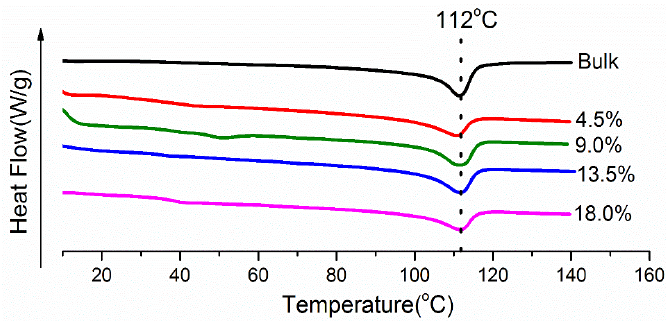
Figure 5. Differential scanning calorimetry (DSC) curves of the Fe 3 O 4 /SBS/LLDPE composites.